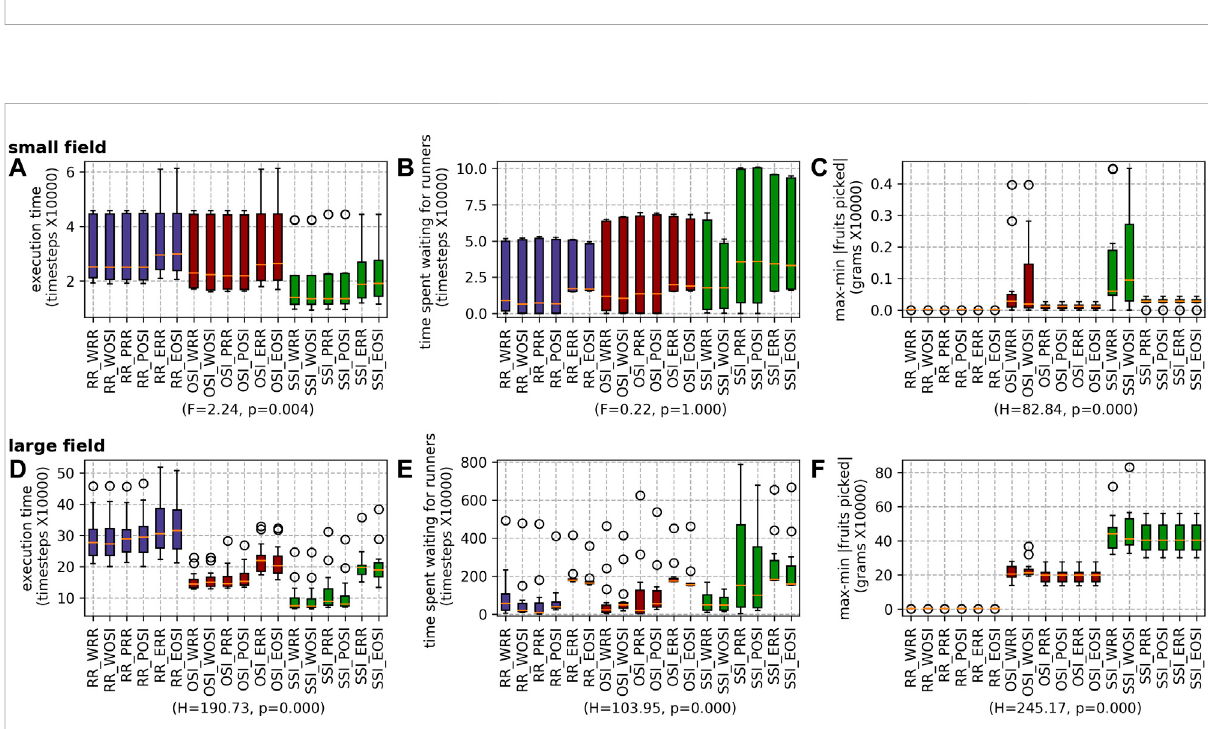
FIGURE 15 Results for all the different scheduling strategies for both farms: the small fi eld (A) execution time, (B) waiting time and (C) max-min |fruits picked|; and the large fi eld (D) execution time, (E) waiting time and (F) max-min |fruits picked|.